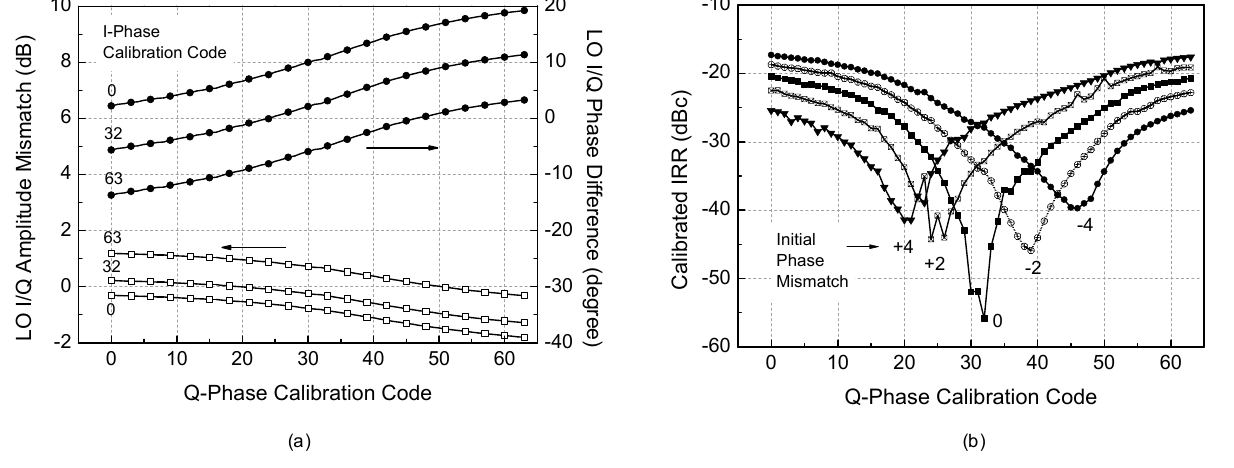
Figure 9. Simulated I/Q phase mismatch calibration ( a ). Tuning characteristics of the phase-tunable LO buffer. ( b ) IRR calibration behavior with respect to the calibration code.